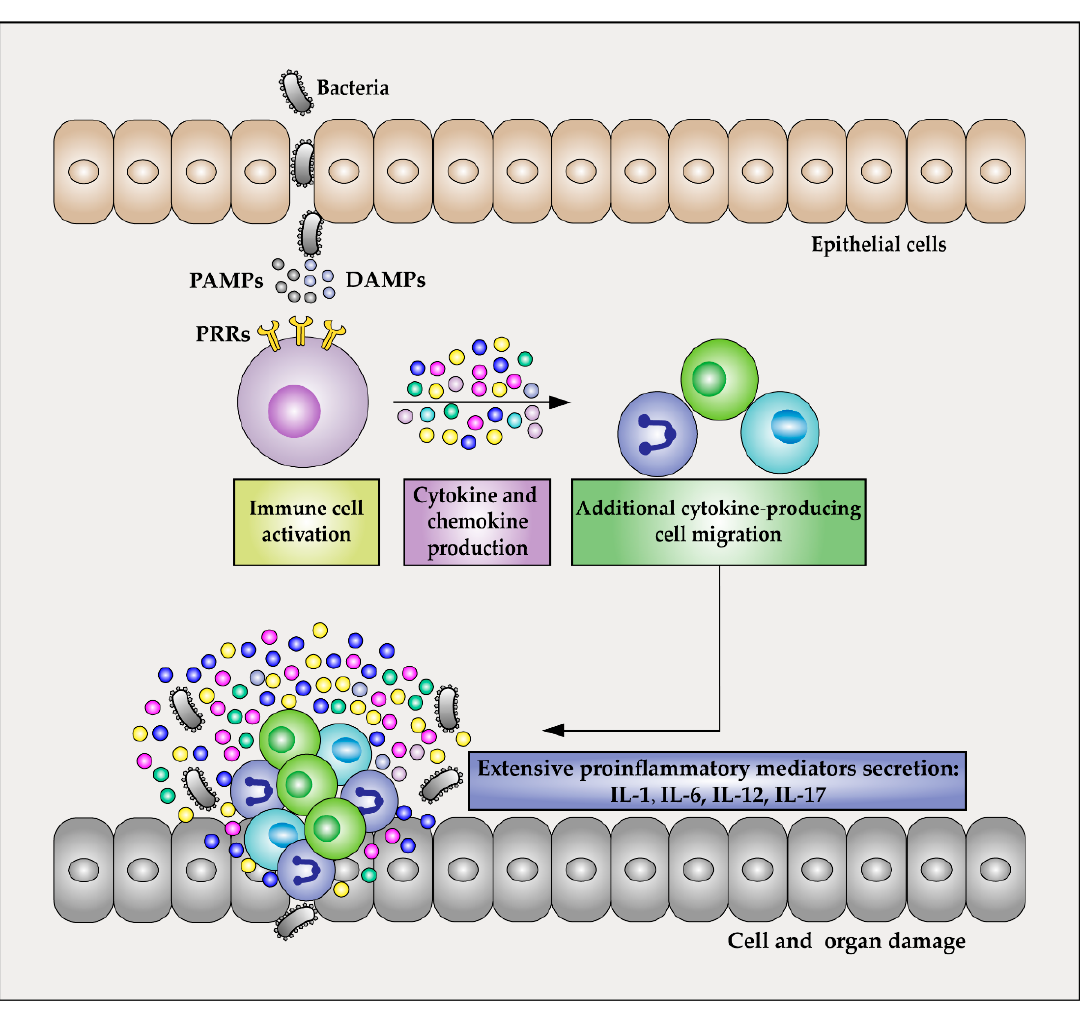
Figure 3. Cytokine storms during sepsis. When microorganisms invade the body, activation of innate immunity is initiated by recognition and binding of pattern recognition receptors (PRRs) to pathogen-associated molecular patterns (PAMPs) or damage-associated molecular patterns (DAMPs) followed by triggering of a series of activation or phosphorylation reactions that induce an inflammatory response. Many pro-inflammatory cytokines have been studied during sepsis-induced cytokine storms, including IL-1, IL-6, IL-12, and IL-17. Sepsis-induced cytokine storm leads to activation and recruitment of leukocytes that promote excessive inflammation that seriously damages cells and organs, often leading to multi-organ failure and death.